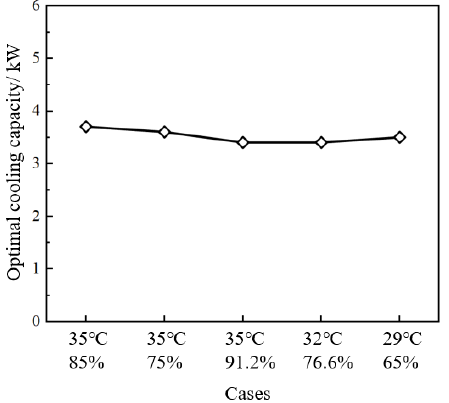
Figure 5. Optimal cooling capacity in different cases.